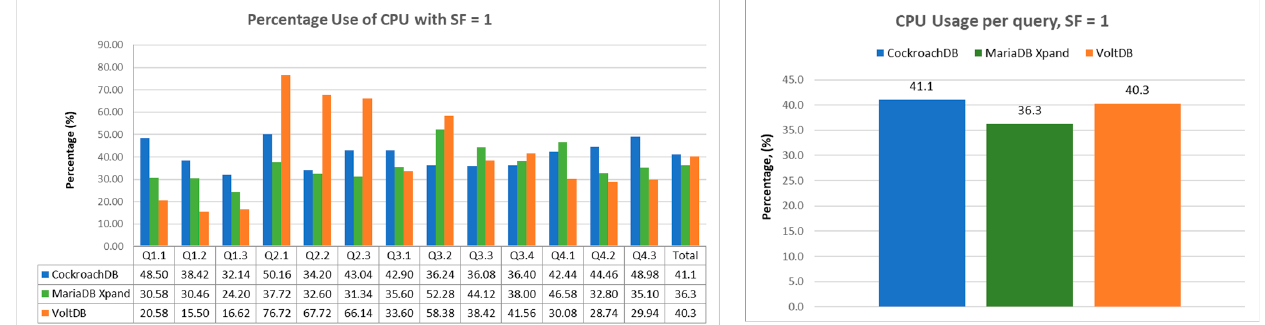
Figure 10. Results of percentage usage per core with SF = 1.